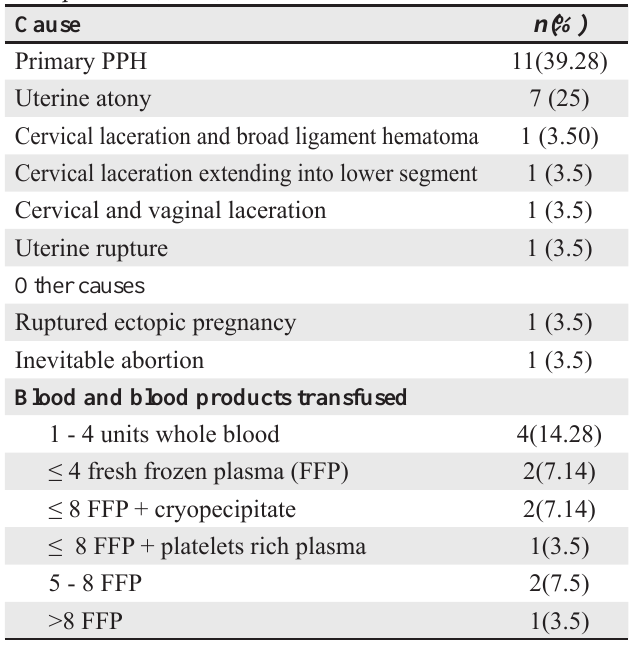
Cervical laceration and broad ligament hematoma